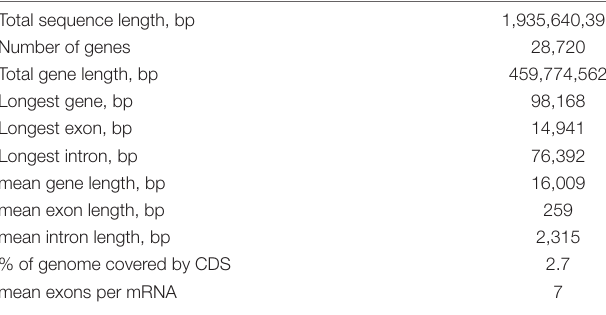
TABLE 3 | Properties of predicted genes in P. indicus